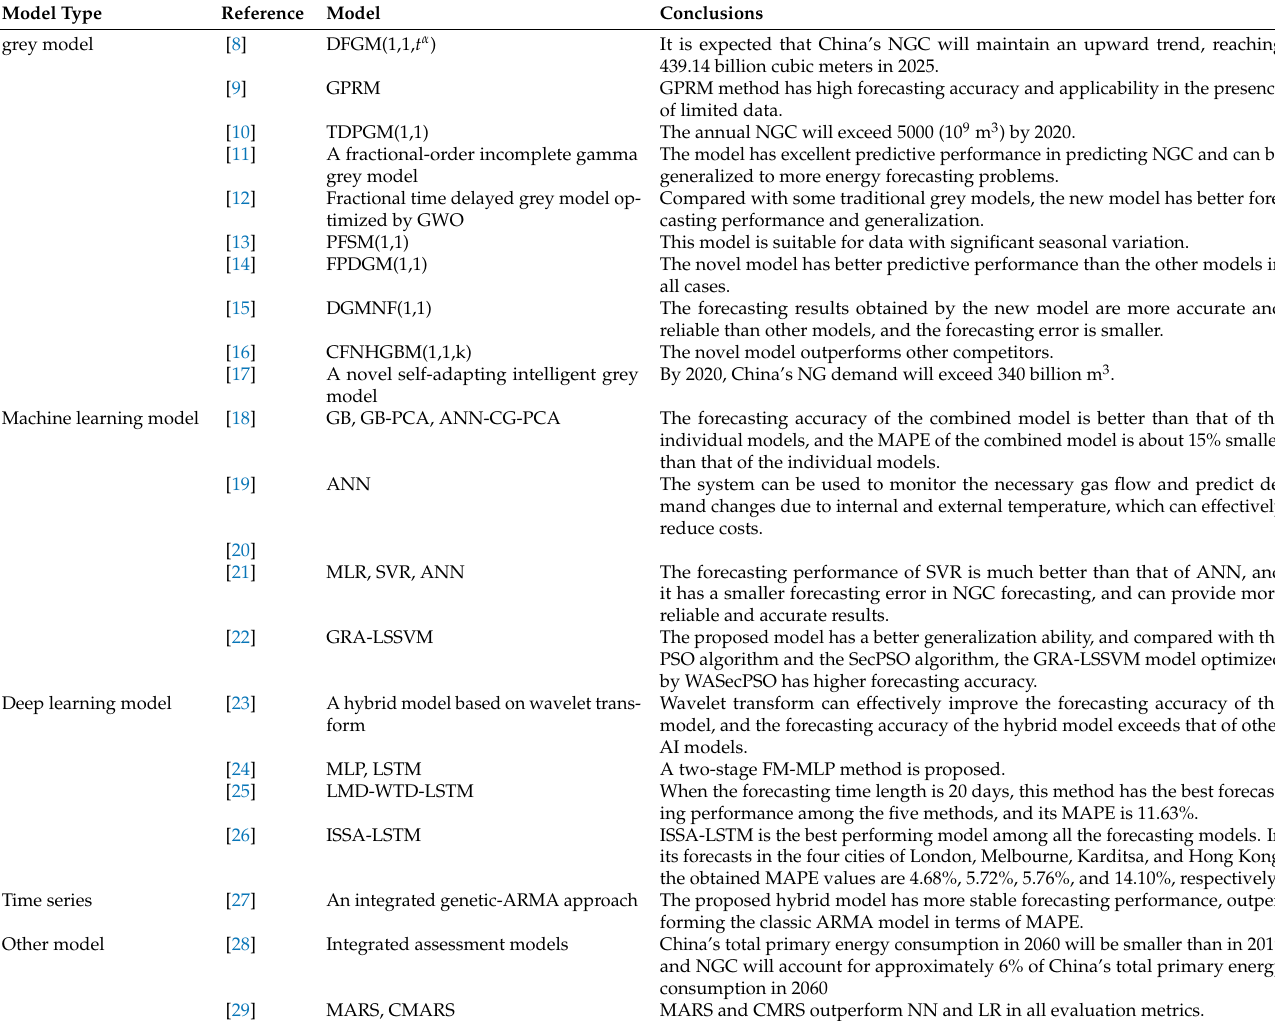
Table 1. Brief summary of literature NG